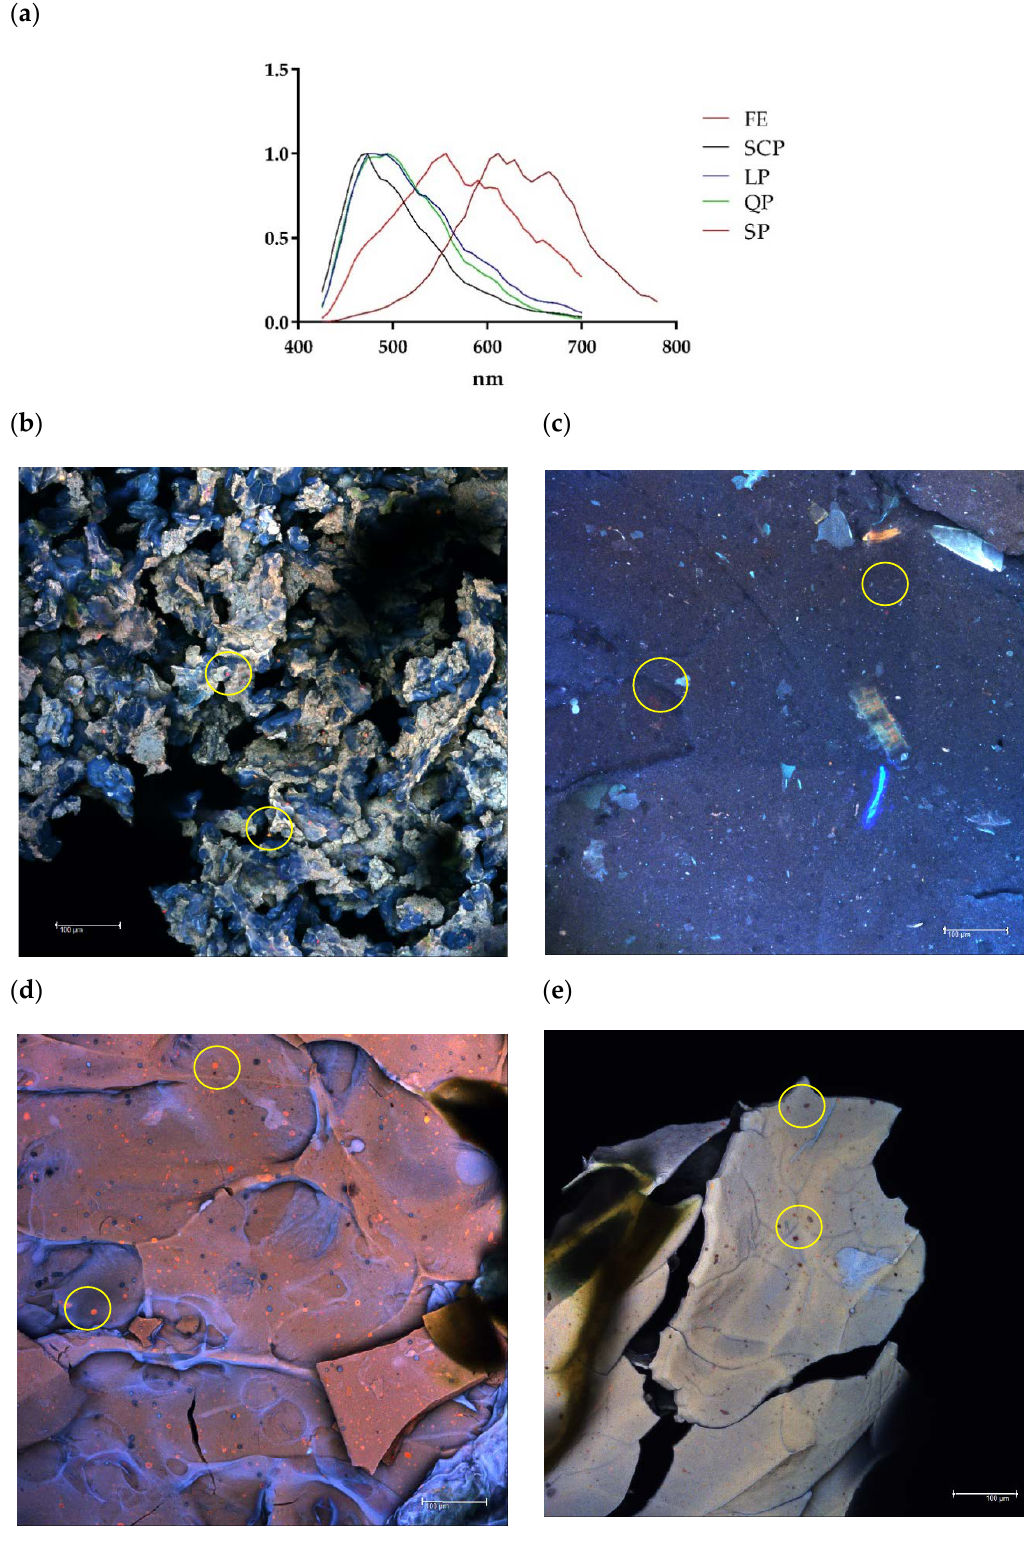
Figure 3. Confocal laser scanning microscopy (CLSM). ( a ) Fluorescence spectrum of free and encapsulated annatto extract; ( b ) encapsulated extract with lentil proteins, ( c ) encapsulated extract with quinoa proteins, ( d ) encapsulated extract with sodium caseinate, and ( e ) encapsulated extract with soy proteins. FE: free extract, LP: lentil protein, QP: quinoa protein, SCP: sodium caseinate, SP: soy protein, scale bar: 100 µ